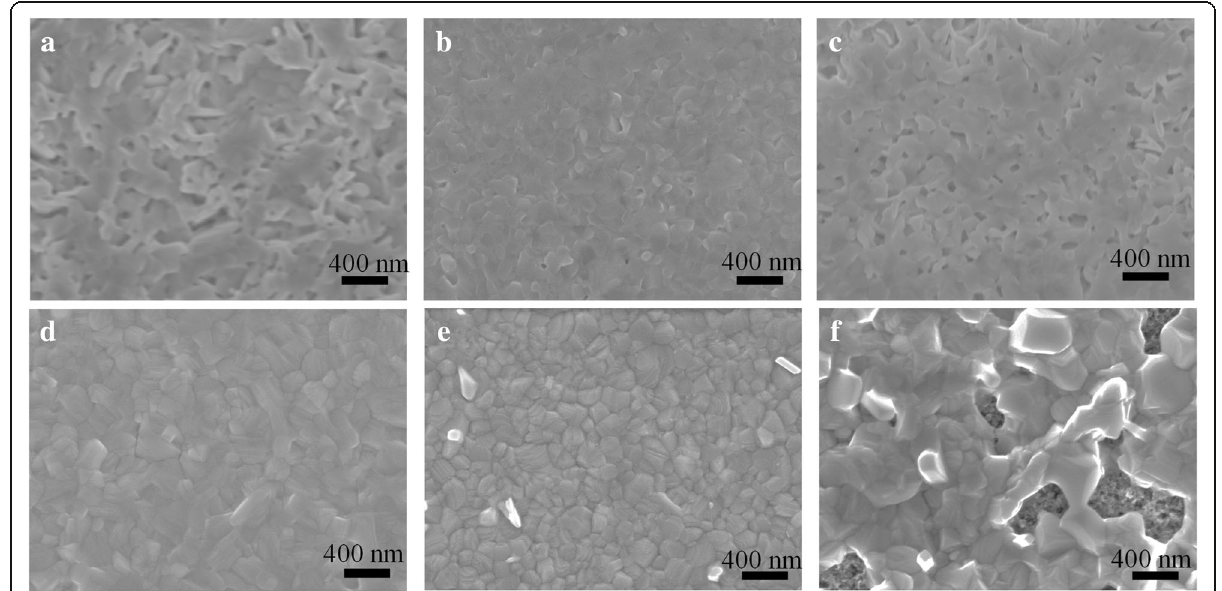
Fig. 2 SEM images of the PbI 2 films (top) and perovskite films (bottom) a , d without DMI, b , e 10% DMI, and c , f 20% DMI